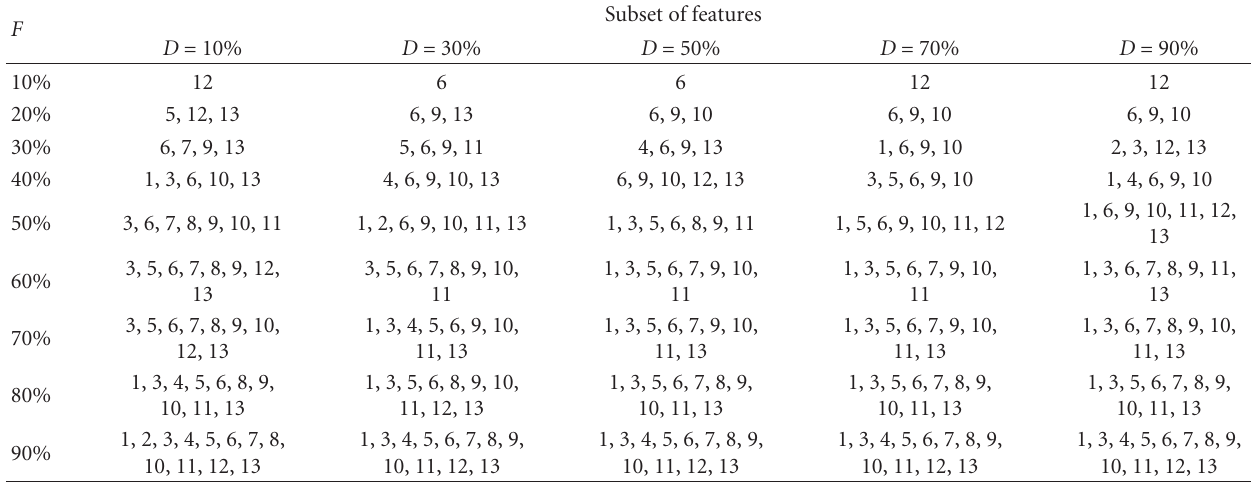
Table 10: Best subsets of features for housing data.